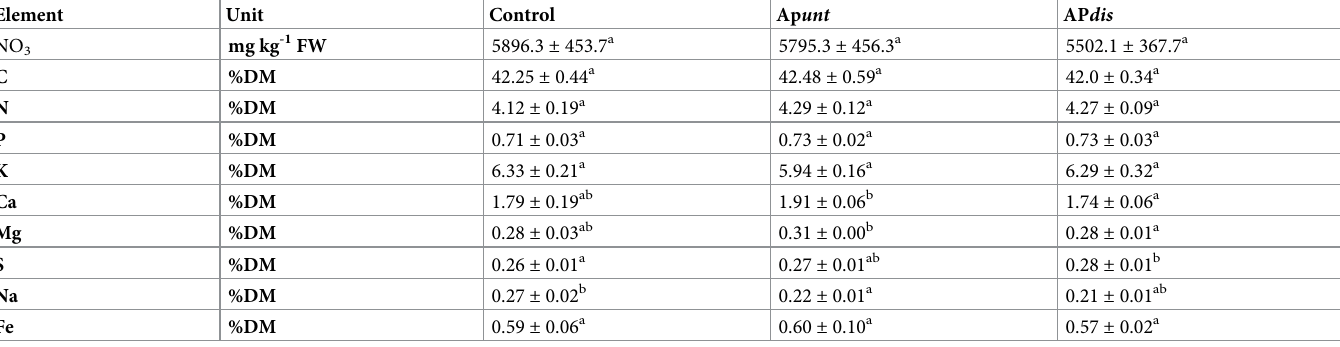
Table 6. Effect of fresh water (control, prepared using fresh and rain water (50:50, v/v), untreated fish water (AP unt ) and disinfected fish water (AP dis ) based nutri- ent solution on nitrate and mineral content in butterhead lettuce. The data represent mean values on dry weight matter (DM) or fresh weight basis (FW, only for NO 3 ) ± standard deviation of four mix samples taken randomly from respective three lettuce heads. Mean values were compared using univariate ANOVA and following tested using post hoc Tukey-HSD test or compared by Kruskal-Wallis test (P) and tested using Dunn-Bonferroni test (Mg, Na) (p < 0.05). Significant differences are indicated by different superscript small letters.